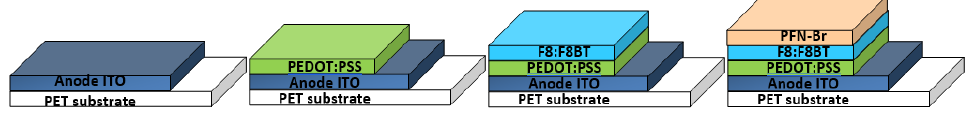
Figure 2. The geometrical structure of the samples for which SE measurements were performed in the sequential steps of the multilayer OLED development.